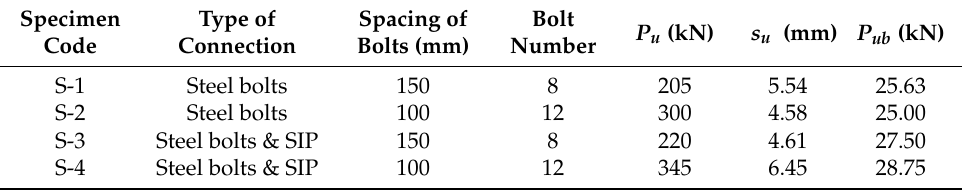
Table 1. Parameters and test results (ultimate load and slip) of the push-out test